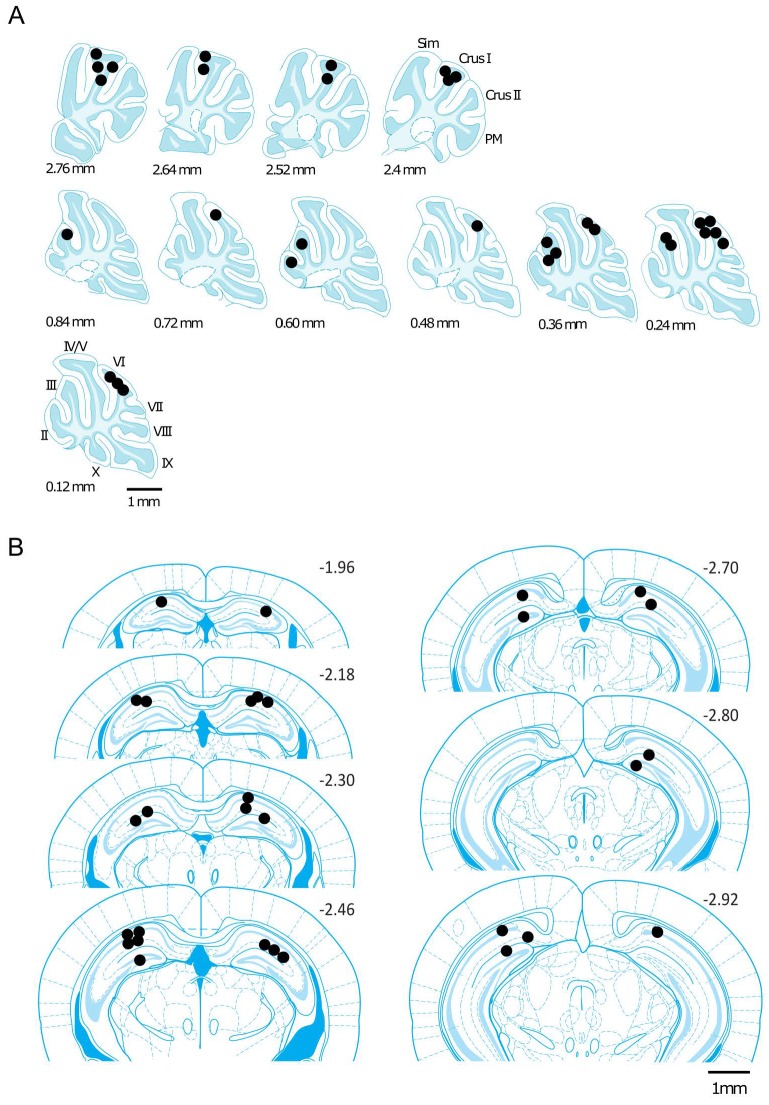
Reconstructed location of the implanted electrodes.The position of the implanted electrodes are represented by black dots on a standard sagittal outline of the cerebellum (A) or coronal outline of the hippocampus (B). The medio-lateral (in A) or rostro-caudal (in B) positions relative to midline or bregma, respectively, are indicated next to the outlines. Abbreviations, II, lobule II; III, lobule III; IV/V, lobule IV/V; VI, lobule VI; VII, lobule VII; VIII, lobule VIII; IX, lobule IX; X, lobule X; Sim, lobule simplex; PM, paramedian lobule.